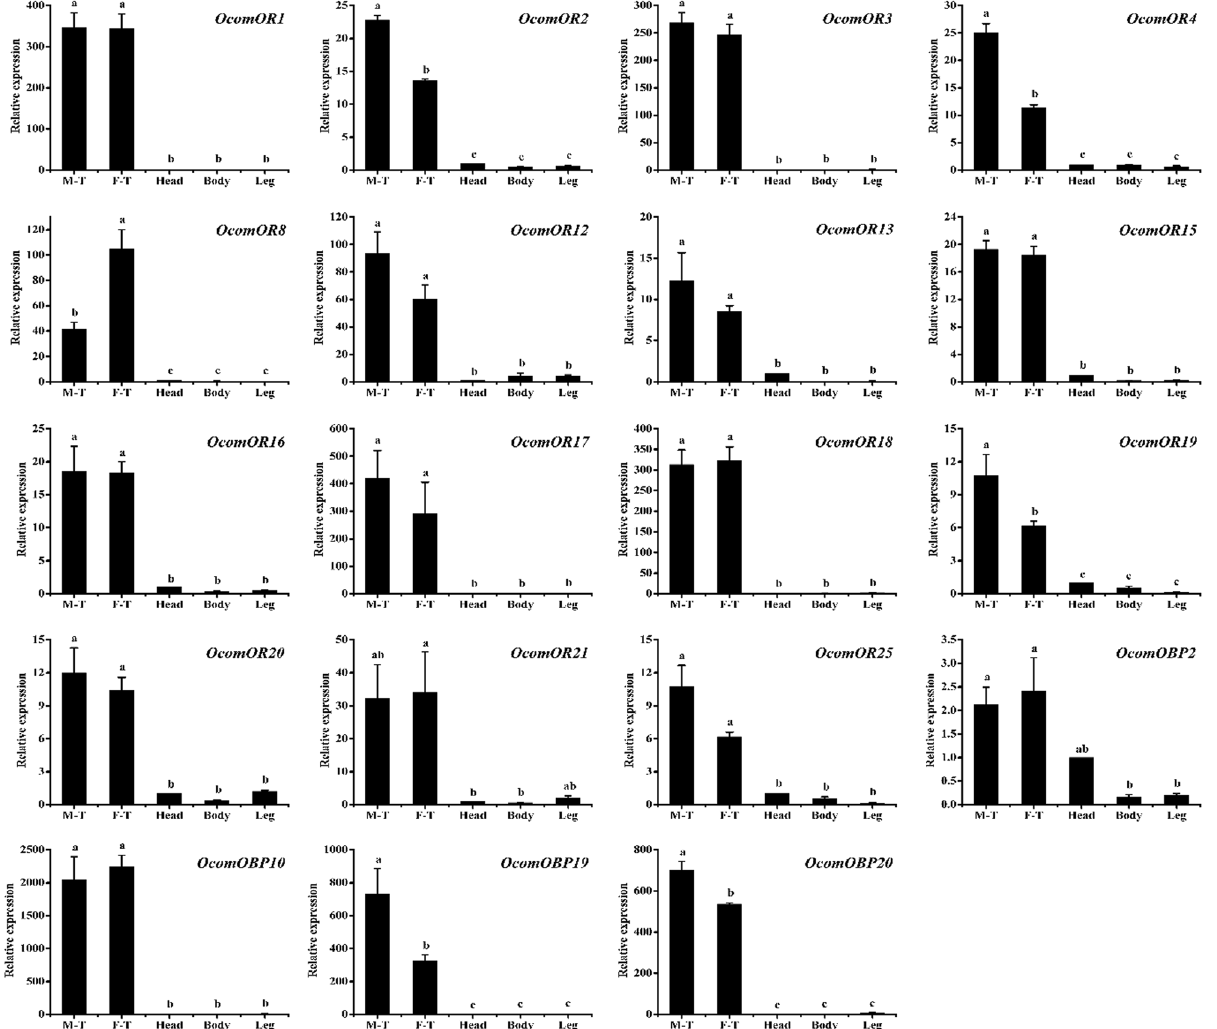
Figure 9. Relative expression levels of 15 ORs and four OBPs in adult antennae, head, leg and the rest of body using qPCR. M-T, male antennae; F-T, female antennae. The relative expression level is indicated as mean ± SE (N = 3). Different capital letters mean significant difference between tissues ( P < 0.05, ANOVA,